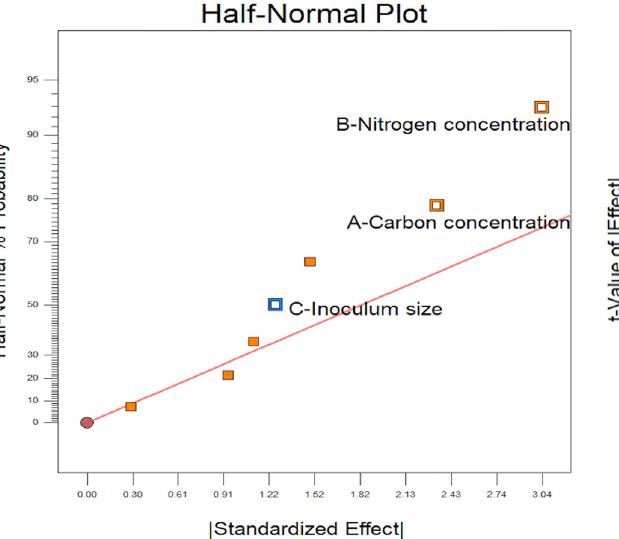
Figure A2: Pareto chart analysis of the e ff ect of di ff erent concen - trations of glucose and peptone and di ff erent inoculum sizes, on BC yield ( g/L ) by P. kudriavzevii USM - YBP2 at 30°C, agitated at 200